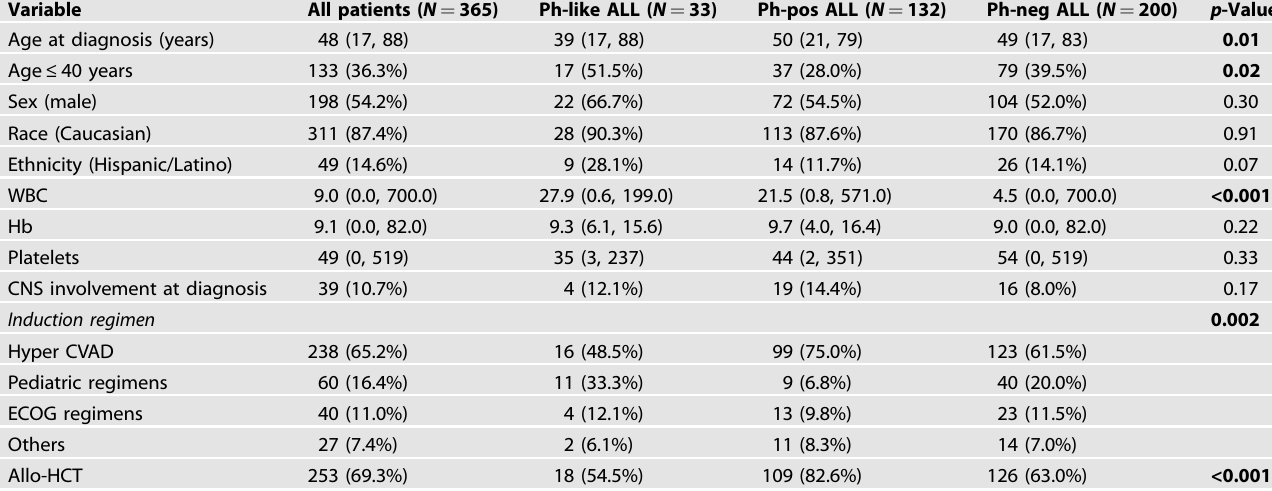
Table 1. Patients